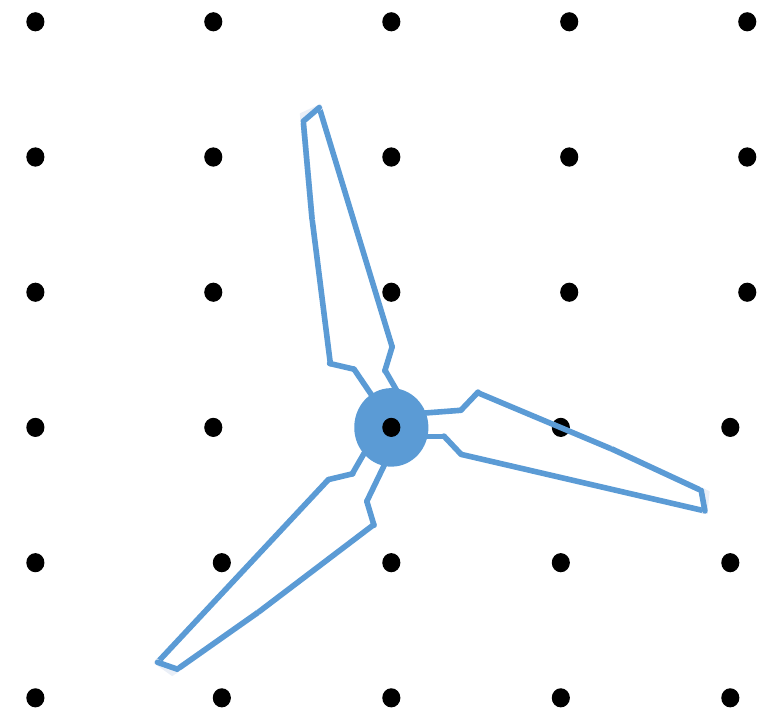
Figure A1. A schematic of the grid around the rotor of the wind turbine. In order to obtain a 3D model of the wind field (in Figure A1, the grid around the rotor has been depicted), one should note that wind time histories at different points are not independent [45]. The coherence function between two points determines the correlation between different time history data in the grid. In general, the coherence function between two points j and k in the grid is defined below: